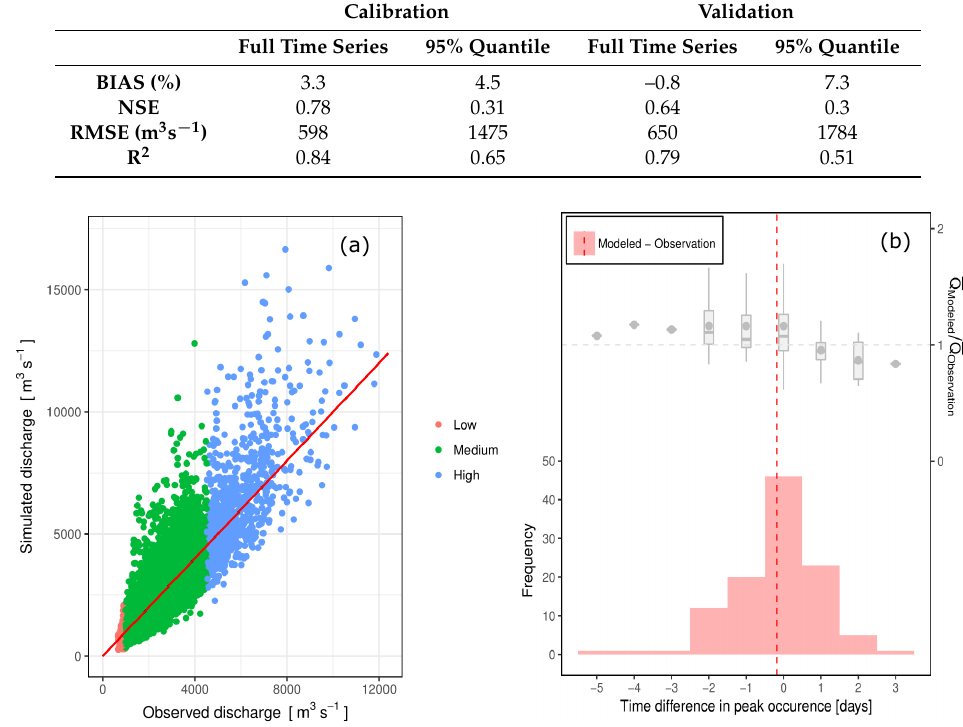
Figure 3. ( a ) Observed versus modeled daily discharge at Lobith for the period between 1951 and 2000. Colors indicate three ranges based on observed percentiles: Low (<5%, red), Medium (5%–95%, green) and High (>95%, blue). The solid red line represents the 1:1 slope. ( b ) Distribution of the difference between observed and modelled time of occurrence of discharge wave peak (red columns). The red dashed line represents the mean time error. The box plot represents the ratio of modeled and observed mean discharge for all wave peaks within a time difference interval. The grey line represents a mean ratio of 1. The grey point represents the mean of the ratio for each